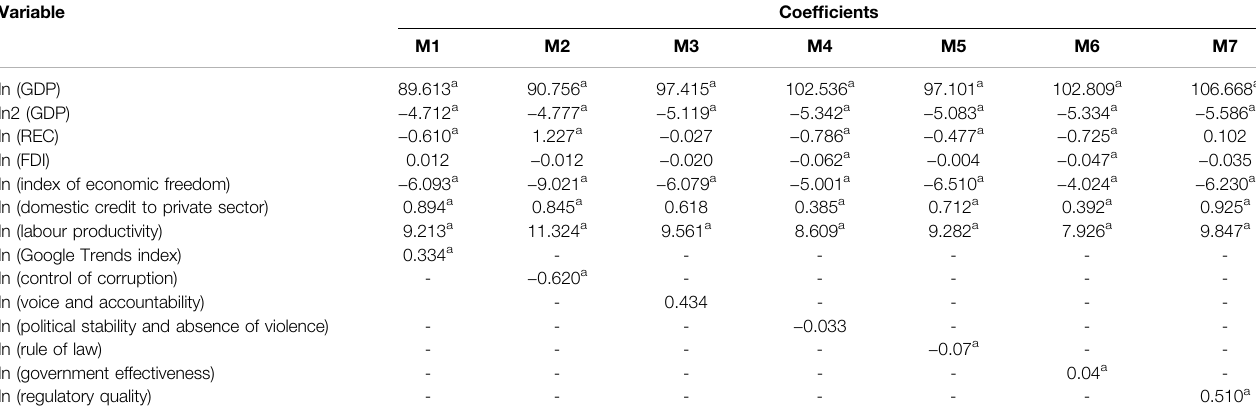
TABLE 7 | Robustness check (additional variable: labor productivity) Panel DOLS models to explain GHG emissions in the 10 CEE countries (2006 – 2019).